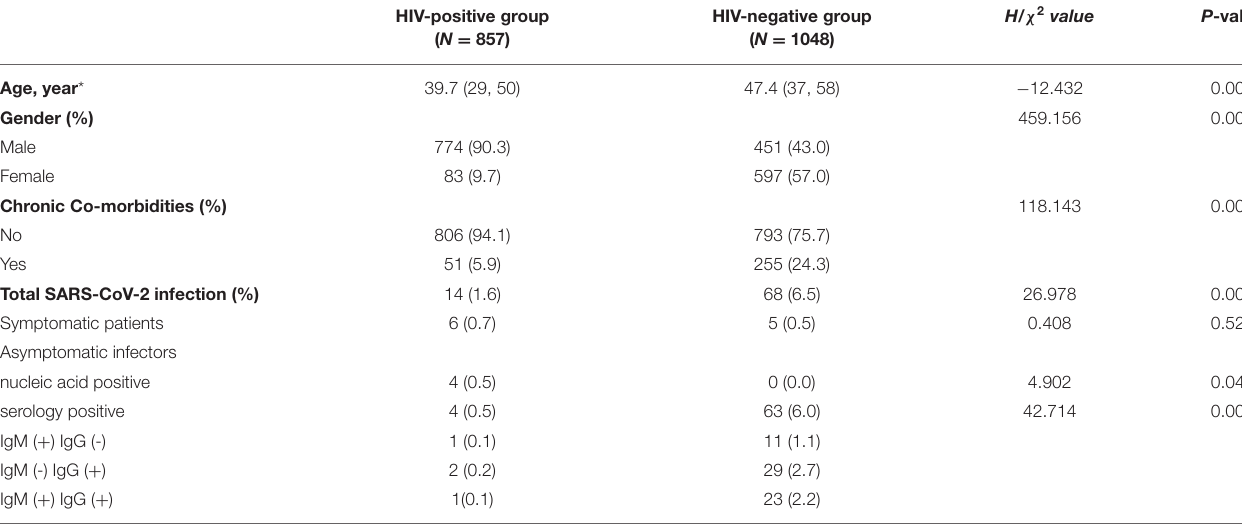
TABLE 1 | SARS-CoV-2 infection between HIV positive and negative group in Wuchang District, 2020 ( N = 1905).